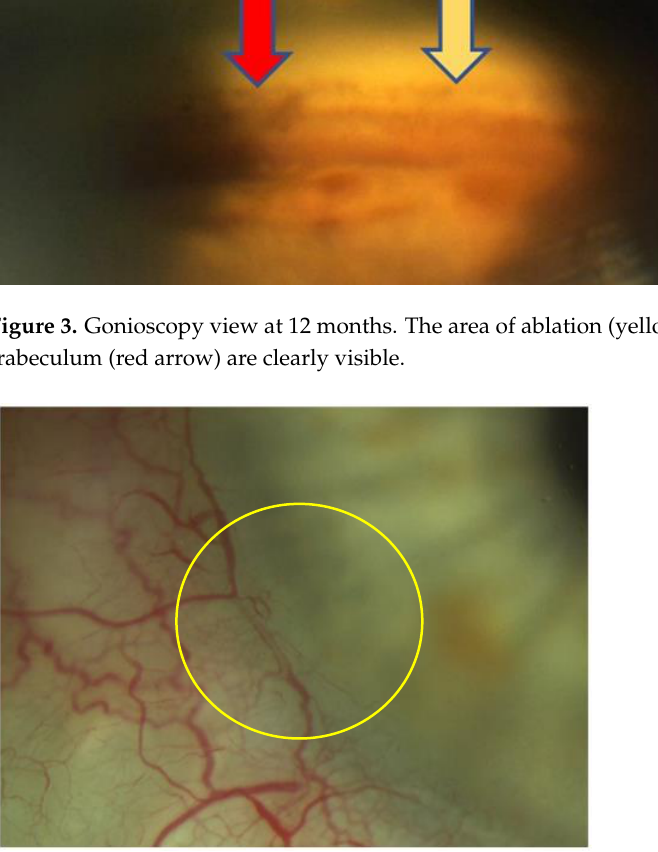
Figure 4. Visualization of the aqueous veins 12 months after surgery (yellow circle). 109